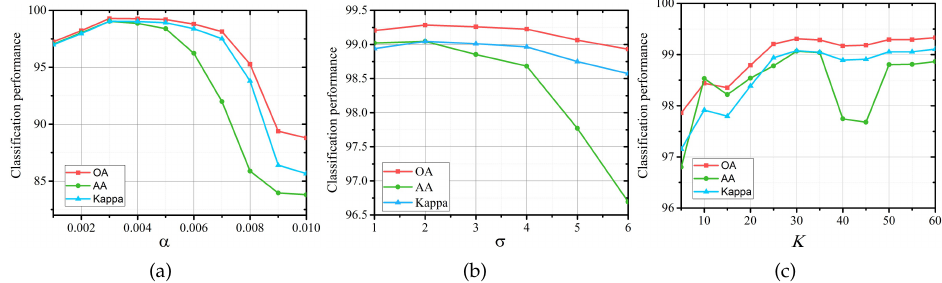
Figure 8. The influence of the proposed multilevel structure extraction (MSE) with different parameters. ( a ) The smoothing parameter α . ( b ) The window size σ . ( c ) The number of the fused features K